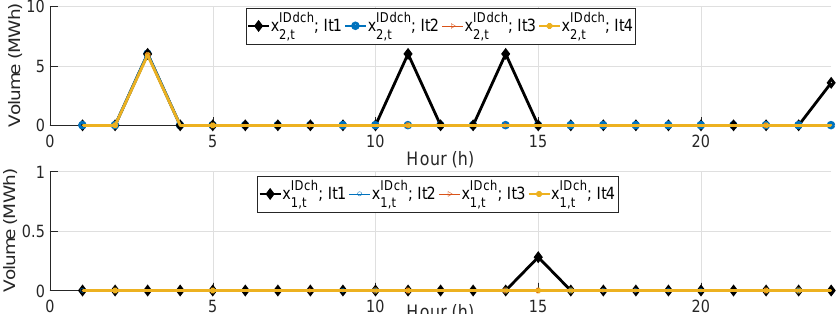
Figure 6. The optimal coordinated bidding in the intra-day market for four iterations of rolling planning ( χ = 0.1).